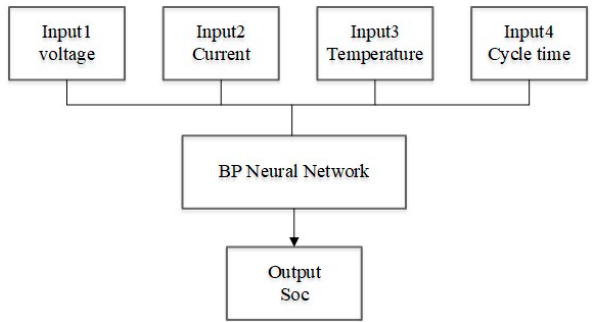
Figure 3. Training sample collection.